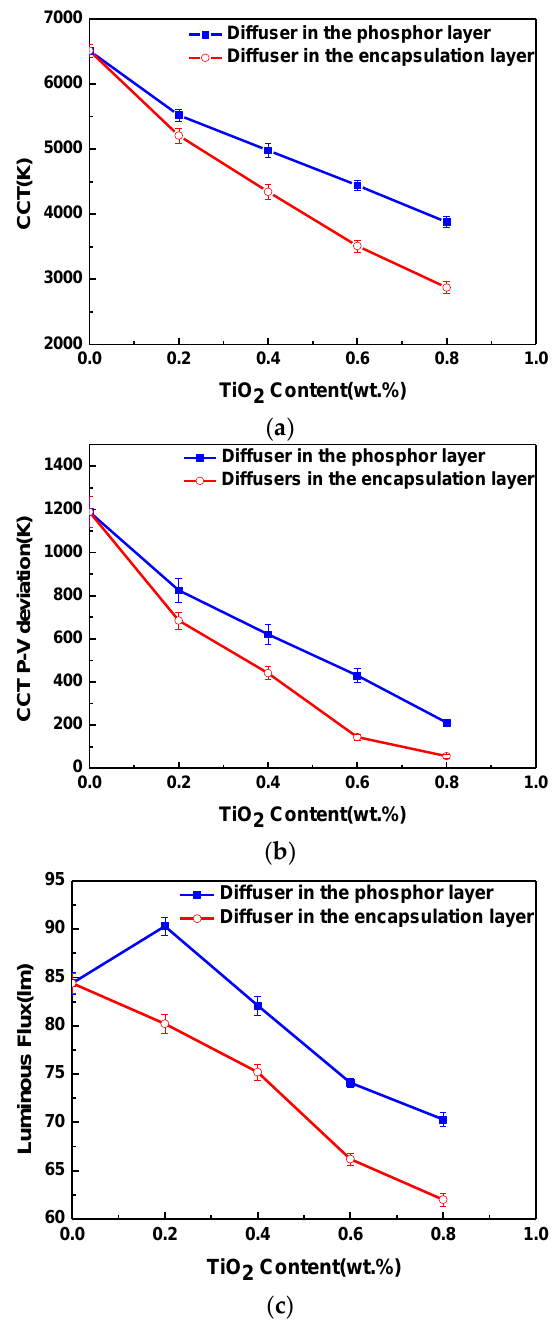
Figure 3. ( a ) The correlated color temperature (CCT), ( b ) the CCT P-V deviation, and ( c ) the luminous flux of the remote phosphor white LEDs for different TiO 2